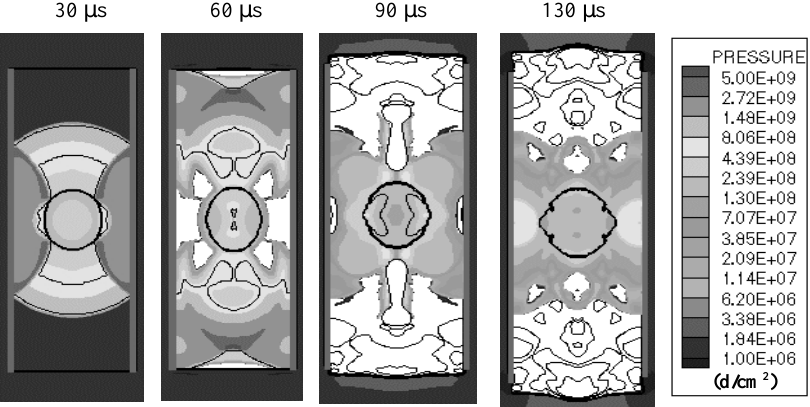
Fig. 9. Cavitation collapse in the rigid, single wall cylinder